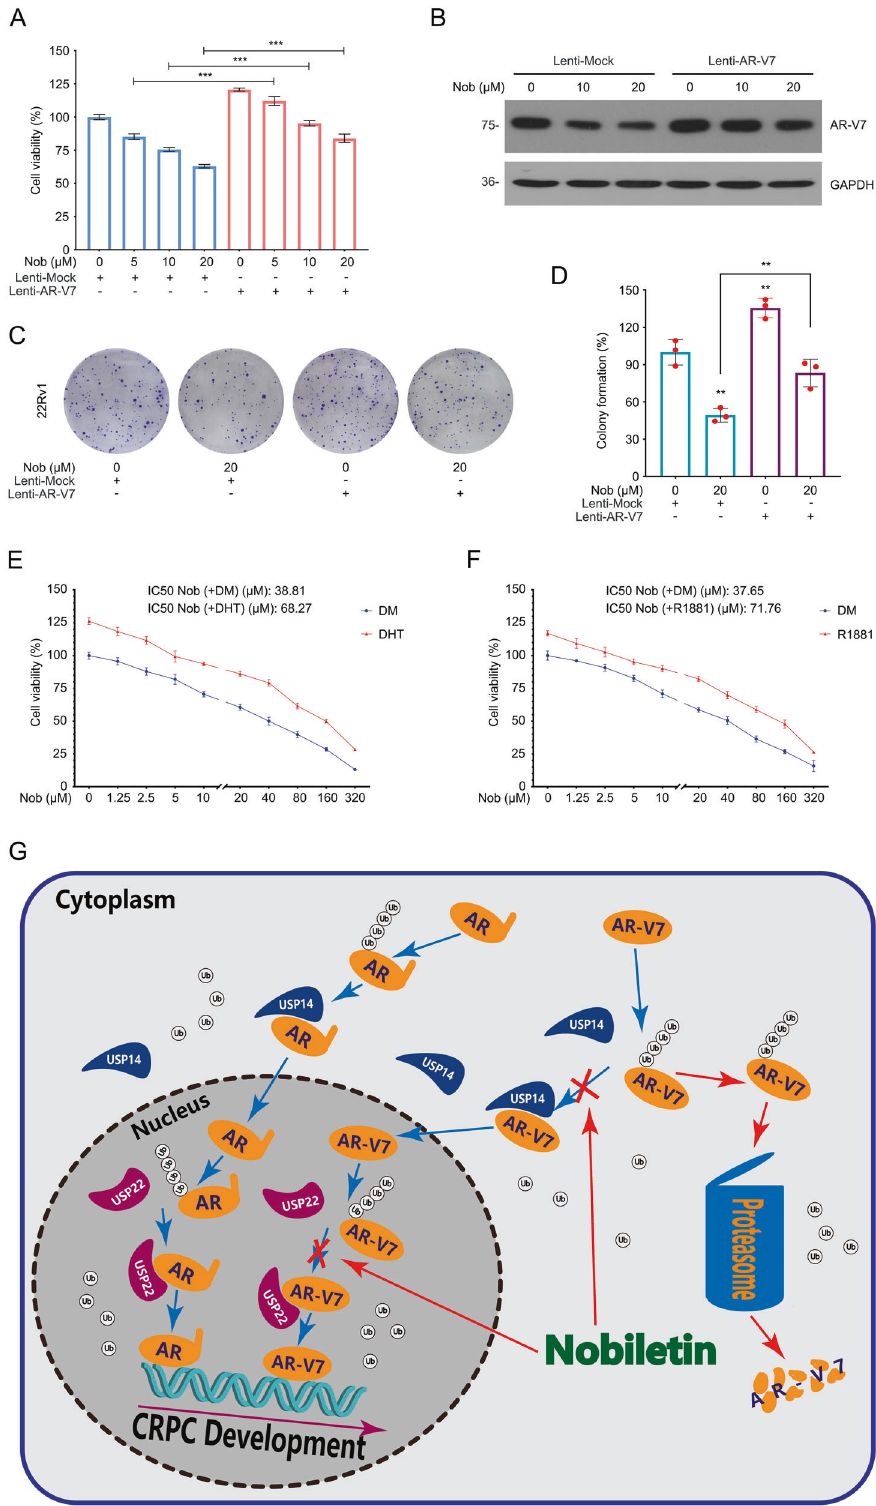
Fig. 7 Nobiletin induced AR-V7-dependent inhibition of proliferation in PC. A CCK8 analysis of 22Rv1 cells transfected with lentiviruses containing AR-V7 plasmids or control plasmids for a week and then exposed to nobiletin for 48 h. Mean ± SD ( n = 3). B Immunoblot of AR-V7 in 22Rv1 cells transfected with lentiviruses containing AR-V7 plasmids or control plasmids for a week and then exposed to nobiletin for 24 h. C Colony formation assay of 22Rv1 cells transfected with lentiviruses containing AR-V7 plasmids or control plasmids for a week and then exposed to nobiletin for 2 weeks. D Quantitative data of C are shown. Mean ± SD ( n = 3). E , F CCK8 analysis of 22Rv1 cells pretreated with or without DHT (10 nM) and R1881(10 nM) for 48 h and then exposed to nobiletin for 48 h. Mean ± SD ( n = 3). G A proposed model of nobiletin- induced anti-CRPC